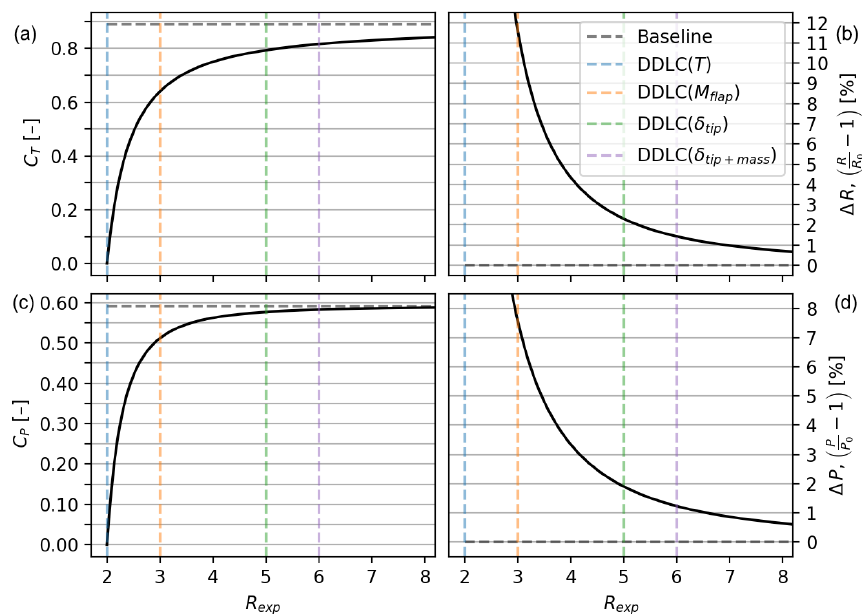
Figure 4. (a) Optimal C T as a function of the constraint R exponent ( R exp ). (c) R exp vs. C P ; notice that the optimal C P curve has a steeper slope and hugs the baseline closer than C T . (b) R exp vs. relative change in radius (cid:49)R . (d) R exp vs. relative change in power capture ( (cid:49) ˜ P ). Despite the similar shape of the curves, a difference between the two is that (cid:49)P ( R exp → 2) = 50%, while (cid:49)R ( R exp → 2) → ∞ . The vertical lines represent each of the example constraints ( ∗ DDLC: design-driving load